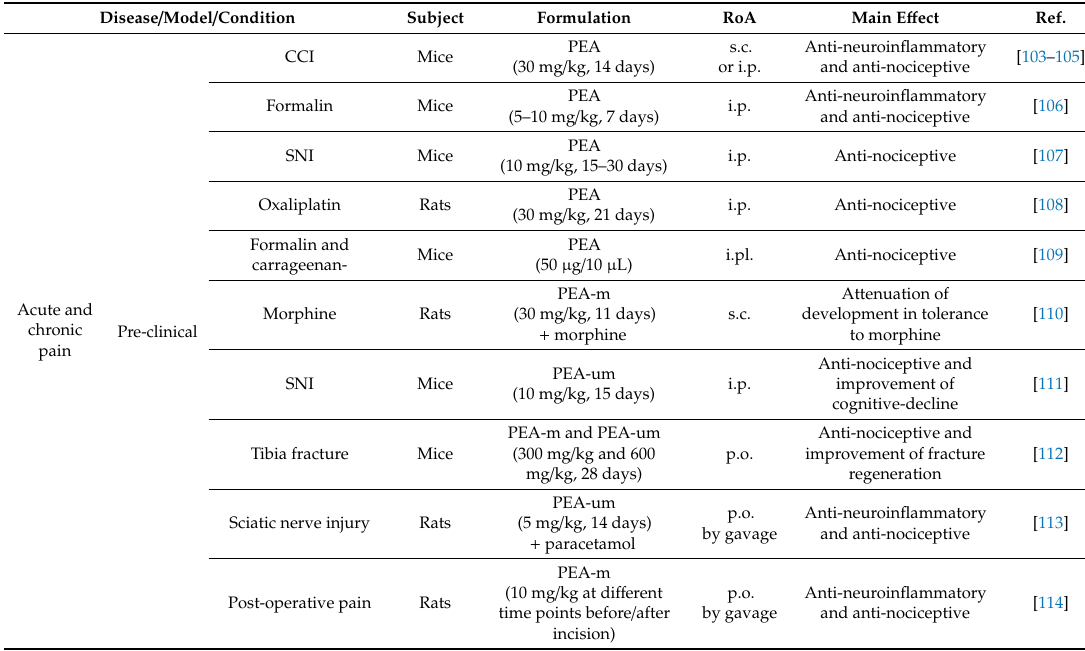
Table 3. Pre-clinical and clinical e ff ects of PEA in micronized and co-micronized formulations in pain syndromes sustained by neuroinflammation. Abbreviations: bid, twice a day; CCI, chronic constriction injury; FSMP, food for special medical purpose; i.p., intra-peritoneal; i.pl., intra-plantar; NP, neurophatic pain; p.o., oral. PEA-m, micronized PEA; PEA-um, ultra-micronized PEA; PEA, palmitoylethanolamide; s.c., subcutaneous; SNI, spared nerve injury. Disease / Model /